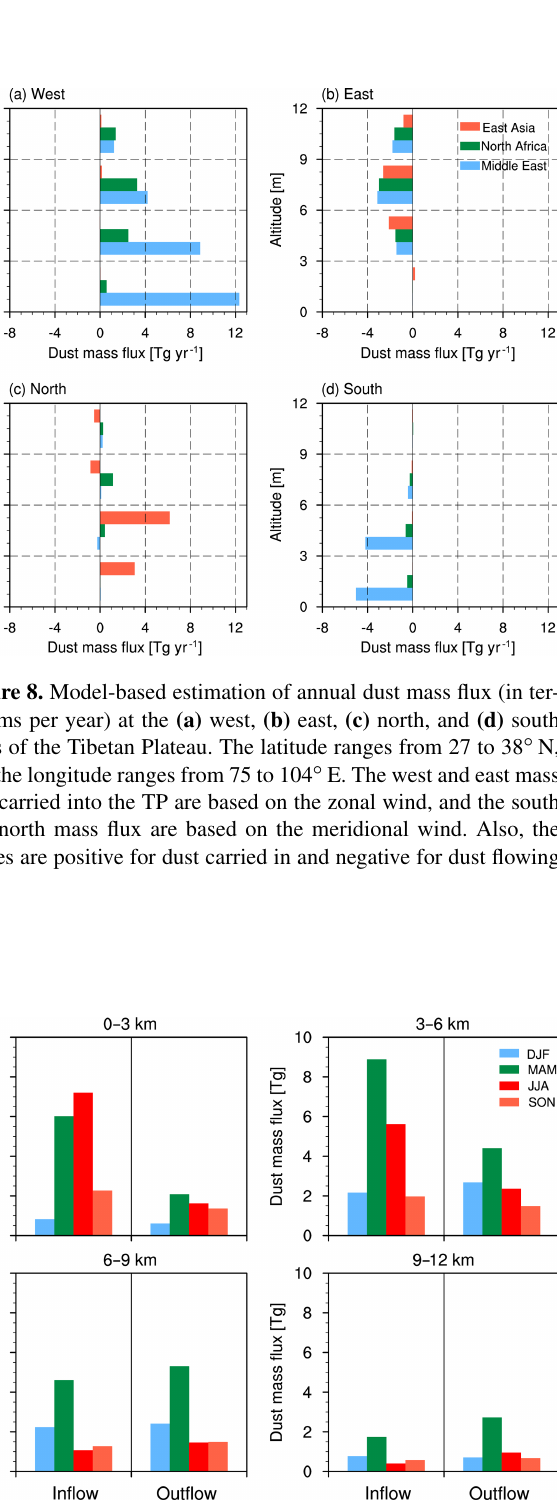
Figure 9. Model-based estimation of annual dust mass flux (tera- grams) inflow and outflow from the TP between 0–3, 3–6, 6–9, and 9–12km from the WRF-Chem simulations averaged over 2010– 2015.